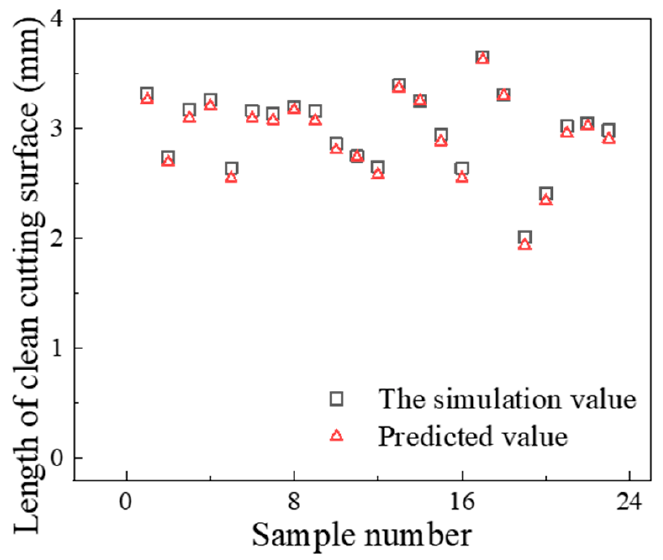
Figure 9. Comparison between network prediction results and finite element results.